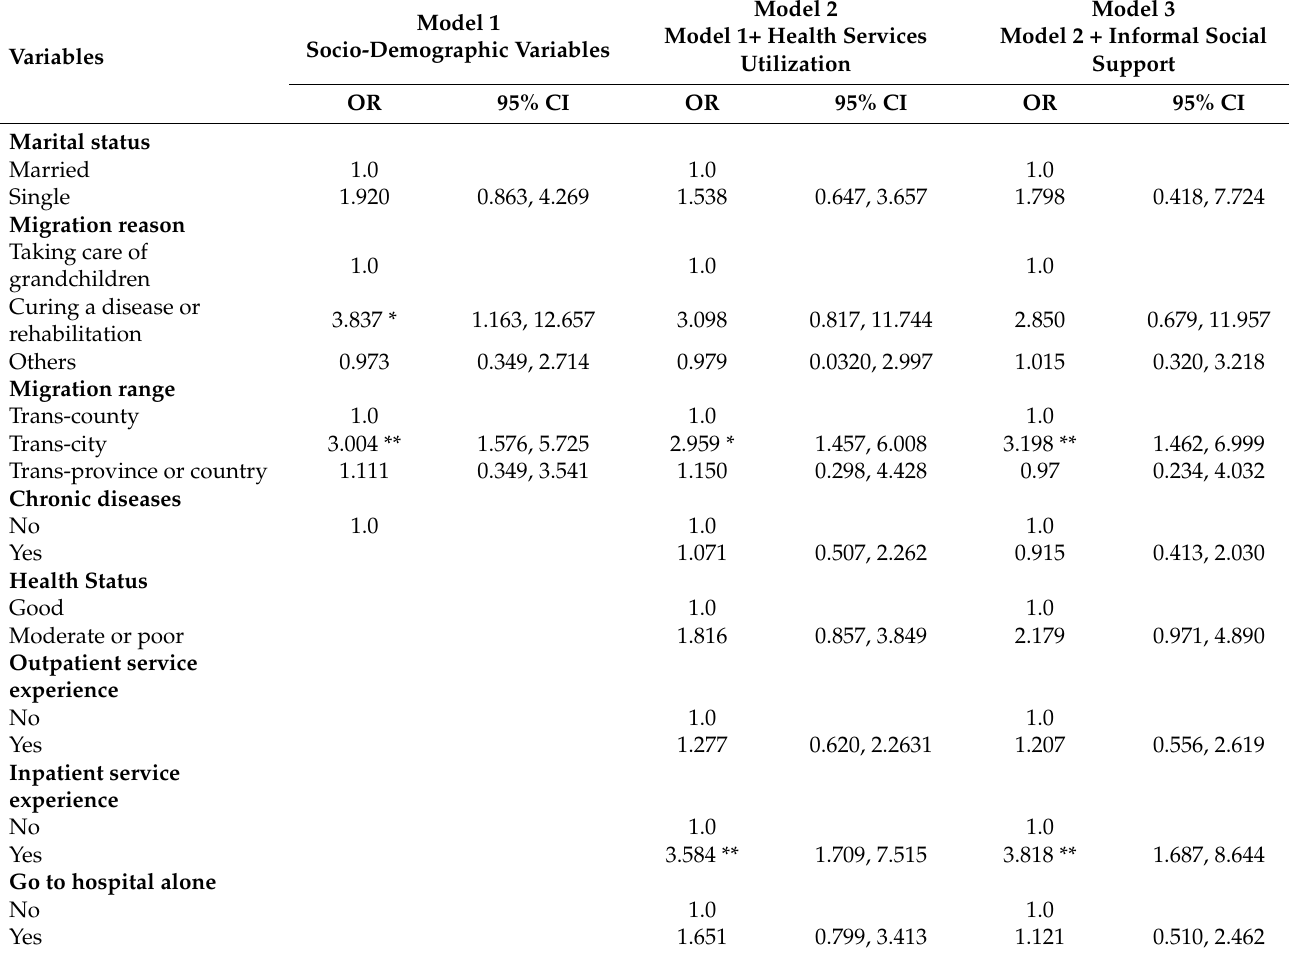
Table 3. Binary logistic regression for relationships between related variables and anxiety of